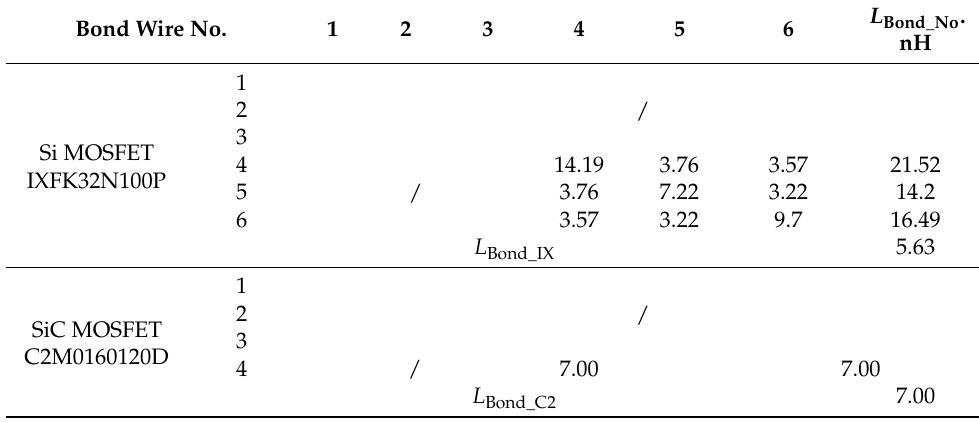
Table A2. Parasitic inductance, L Bond , with three bond wire cutoffs. Bond Wire No.